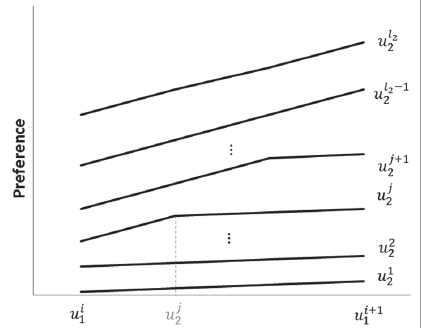
Conditions required to model change in preference difference Result 1 . Preference differences are equal to each other, i.e. , for all 𝑢 values satisfying the following 𝑑 = 𝑑 = ⋯ = 𝑑 (cid:3037) (cid:3037)(cid:2878)(cid:2869) (cid:3047) (cid:2870) ranking: 𝑢 (cid:2870)(cid:3037) < 𝑢 (cid:2870)(cid:3037)(cid:2878)(cid:2869) < ⋯ < 𝑢 (cid:2870)(cid:3047) < 𝑢 (cid:2869)(cid:3036) < 𝑢 (cid:2869)(cid:3036)(cid:2878)(cid:2869) Result 2 . Preference differences are equal to each other, i.e. ranking: 𝑢 (cid:2870)(cid:3047) > ⋯ > 𝑢 (cid:2870)(cid:3037)(cid:2878)(cid:2869) > 𝑢 (cid:2870)(cid:3037) > 𝑢 (cid:2869)(cid:3036)(cid:2878)(cid:2869) > 𝑢 (cid:2869)(cid:3036) Result 3 . Preference differences increase or decrease monotonically or they are equal to each other. More precisely, values one of the following three rankings is valid for all 𝑢 (cid:2870) (cid:3036) or larger than 𝑢 (cid:3036)(cid:2878)(cid:2869) which are not smaller than 𝑢 (cid:2869) (cid:2869) simultaneously (for example, 𝑢 (cid:2870)(cid:2869) < 𝑢 (cid:2869)(cid:3036) < 𝑢 (cid:2870)(cid:2870) < 𝑢 (cid:2870)(cid:2871) < 𝑢 (cid:2869)(cid:3036)(cid:2878)(cid:2869) < 𝑢 (cid:2870)(cid:2872) ): 𝑑 > 𝑑 > ⋯ > 𝑑 (cid:3039) (cid:3118) (cid:3039) (cid:3118) (cid:2879)(cid:2869) (cid:2869) 𝑑 < 𝑑 < ⋯ < 𝑑 (cid:3039) (cid:3118) (cid:3039) (cid:3118) (cid:2879)(cid:2869) (cid:2869) 𝑑 = 𝑑 = ⋯ = 𝑑 (cid:3039) (cid:3118) (cid:3039) (cid:3118) (cid:2879)(cid:2869) (cid:2869)